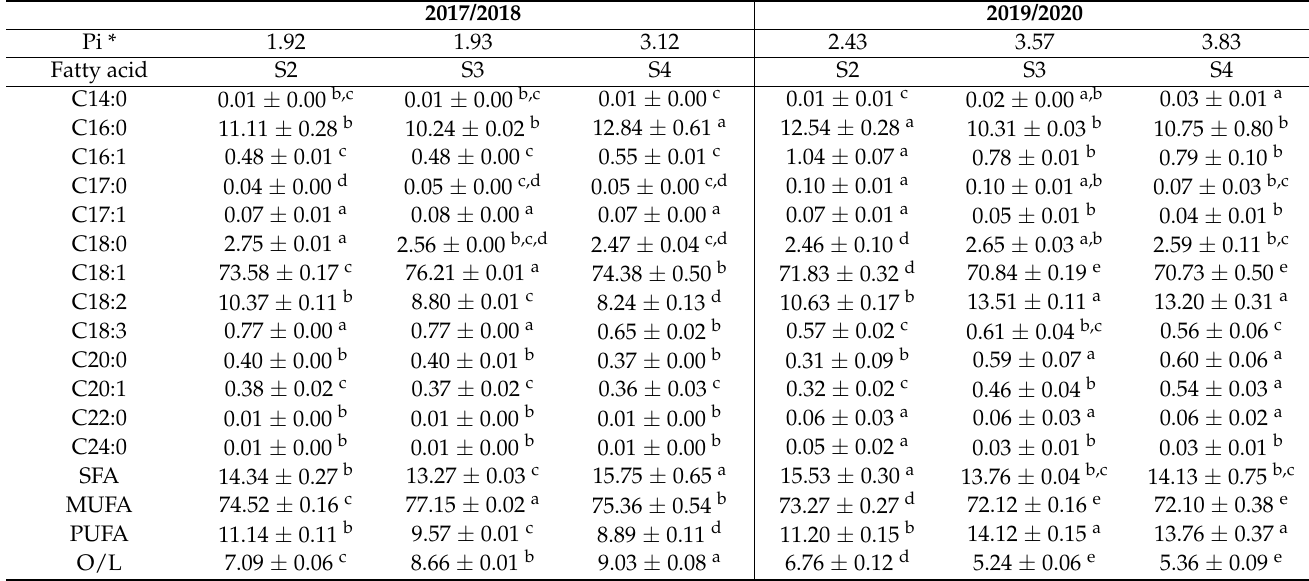
Table 1. Fatty acid composition of the Oliva Rossa virgin olive oils (VOOs) extracted during fruit ripening in two different harvest seasons (mean ± SD, n =